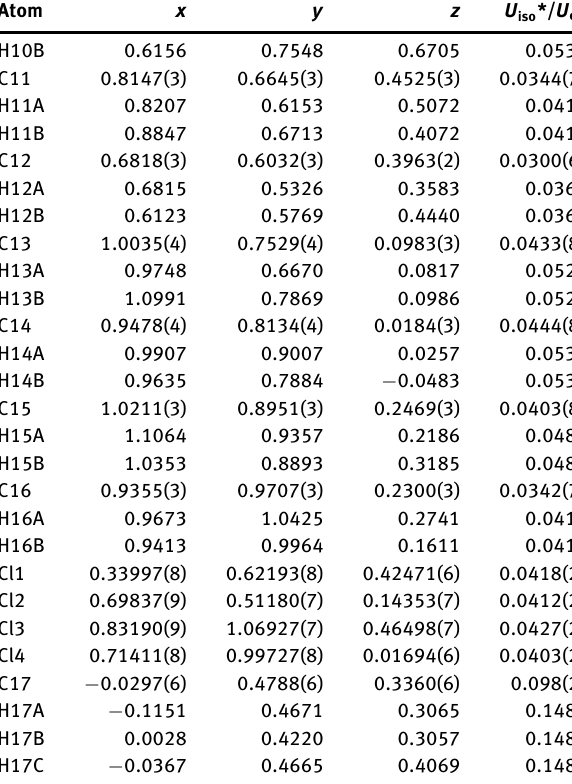
Table 2: Fractional atomic coordinates and isotropic or equivalent isotropic displacement parameters (Å 2